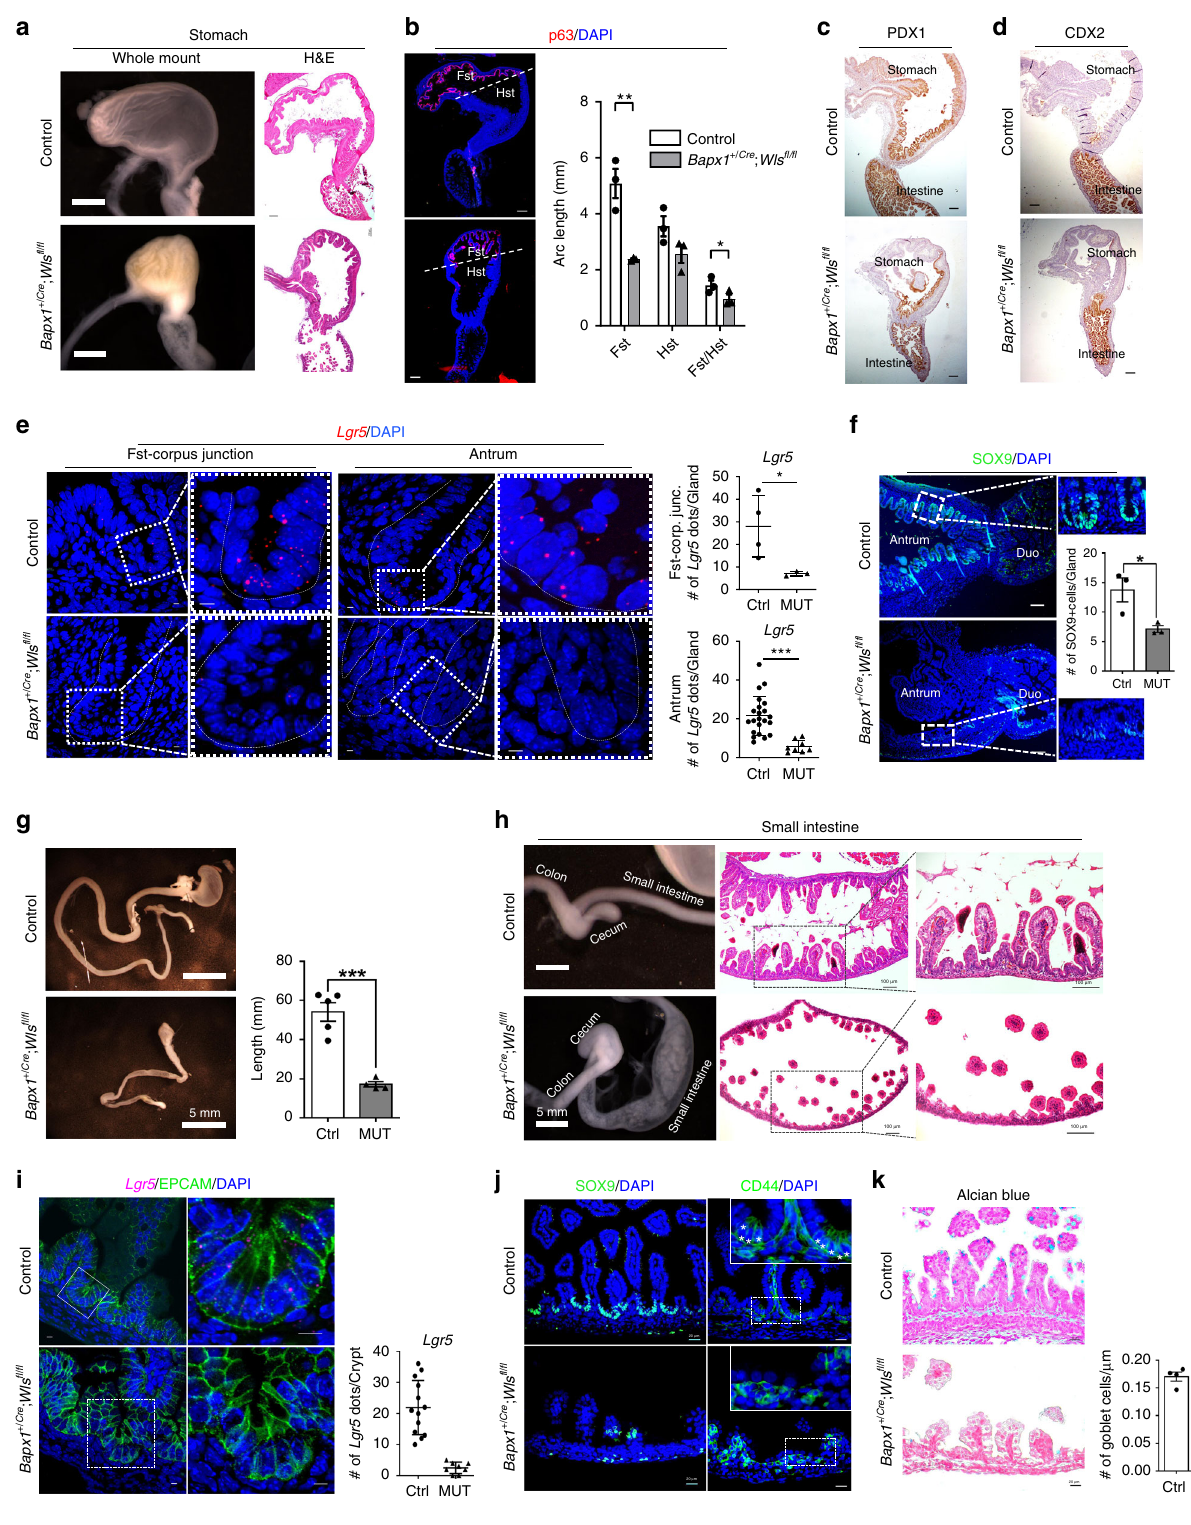
gene numbers of 100 for the stomach and 150 for the intestine were kept for stomach and intestinal data sets. For better visualization, we used the recovered downstream clustering. We chose approximately 2000 highly variable genes to data set to access the expression levels of Wnt and other gut stromal marker genes, project the scaled cpm (counts per million) normalized data into low dimensional which were projected into the feature plot in R package Seurat. For the co- subspace and perform component analysis. Signi fi cant PCs were selected before the expression feature plot, we used the mean value as the cutoff to determine whether curve of the standard deviations reached the plateau. Two-dimensional t-SNE was the gene is expressed in one cell or not. used for visualization. Clustering was based on density clustering. A likelihood- ratio test was used to fi nd the differentially expressed genes for identify classes 57 . To overcome the dropout effect in single cell data, we used MAGIC as previously Cell types comparison between the stomach and intestine . We used an average described 26 . We ran the MAGIC with the same parameters ( k = 10, a = 15) in both expression level of the top 30 marker genes as the feature for each cluster in both NATURE COMMUNICATIONS| (2020) 11:334